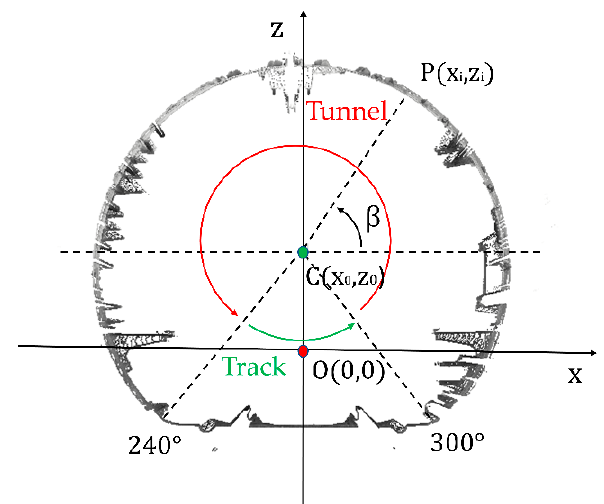
Figure 2. Schematic of the track and tunnel